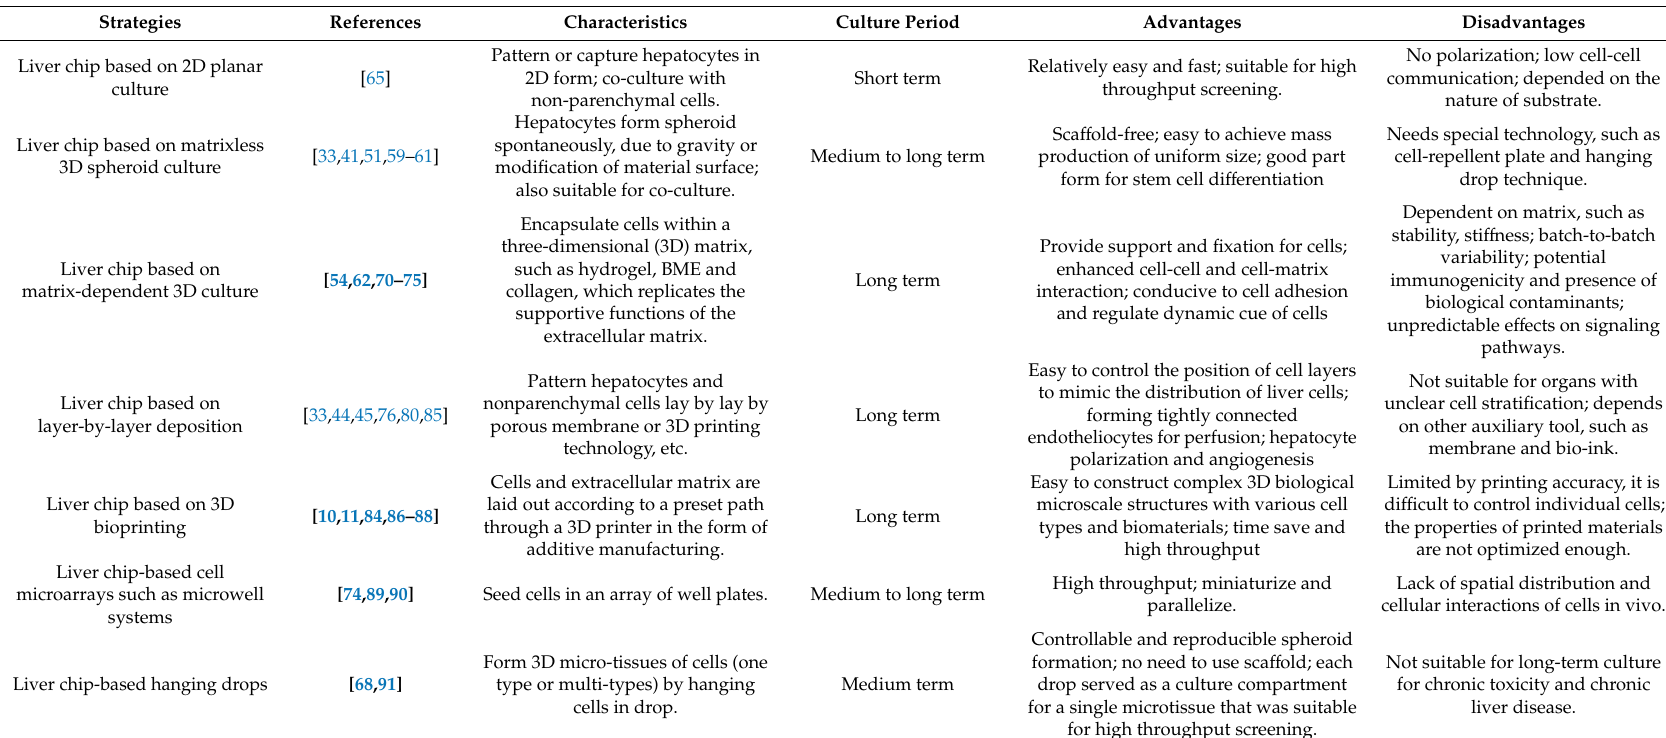
Table 4. Summary of the strategies used for liver-on-chip